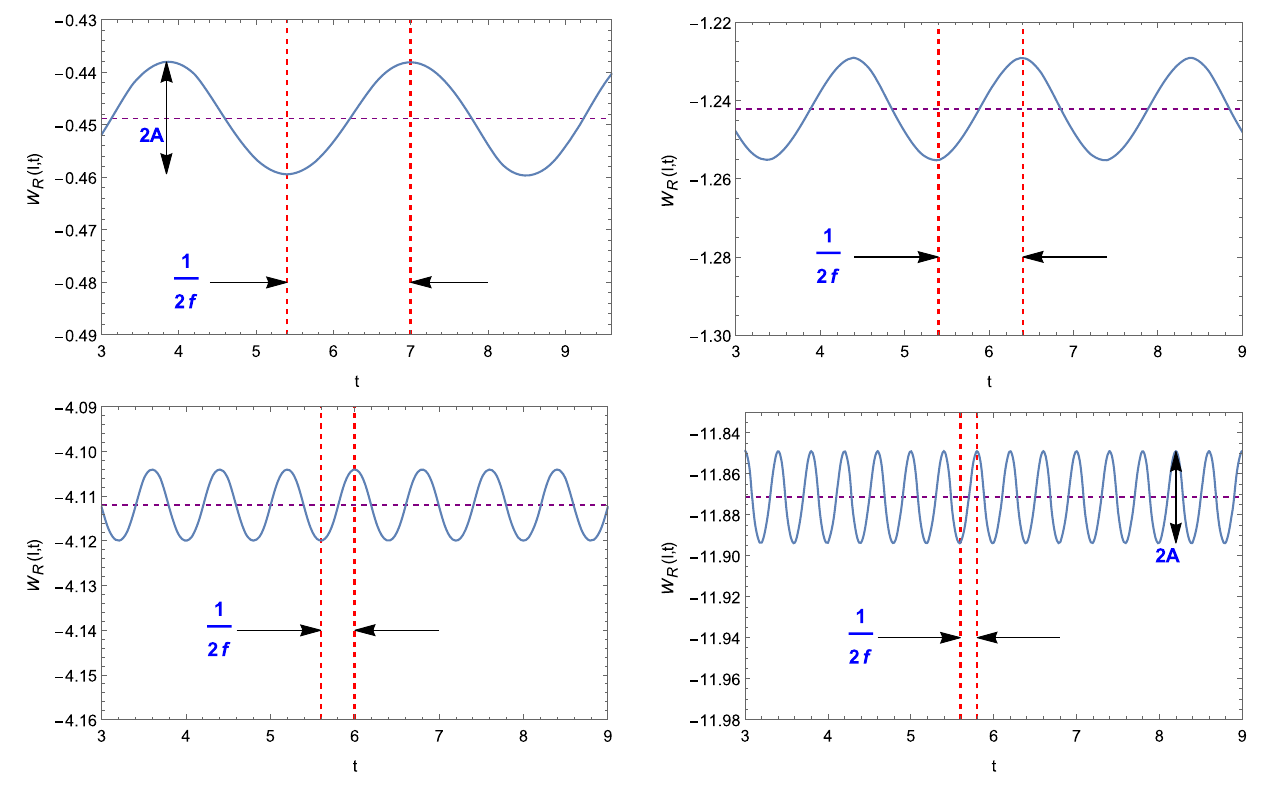
Fig. 4 The expectation value of the Wilson loop in terms of boundary time for ν = 1 (top-left), ν = 2 (top-right), ν = 3 (bottom-left) and ν = 4 (bottom-right). For all figures we set k = 0 . 3, T l = 1. The static potential is V ( l ) = − 0 . 4488 , − 1 . 2422 , − 4 . 1120